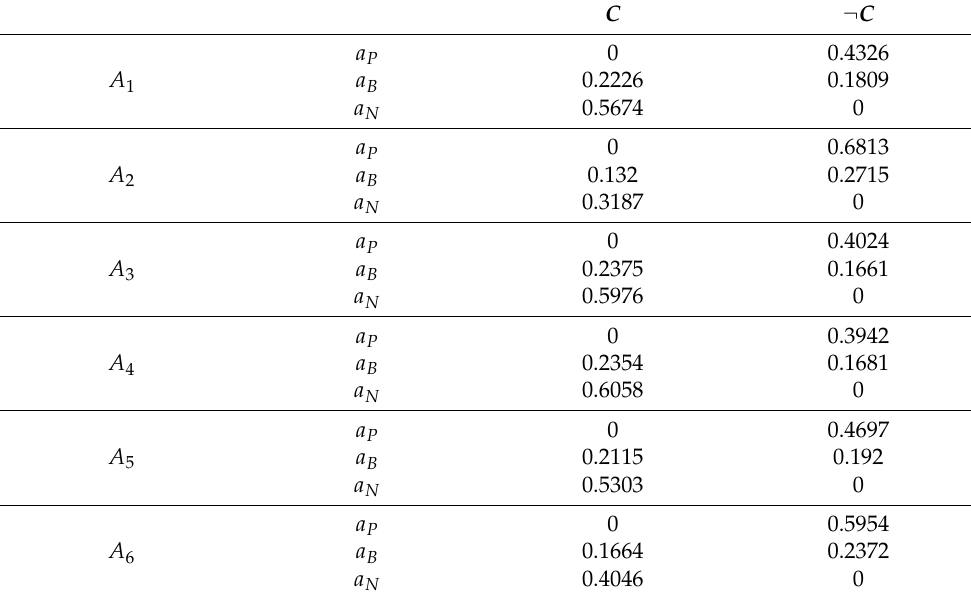
Table 11. The comprehensive relative loss functions of Example